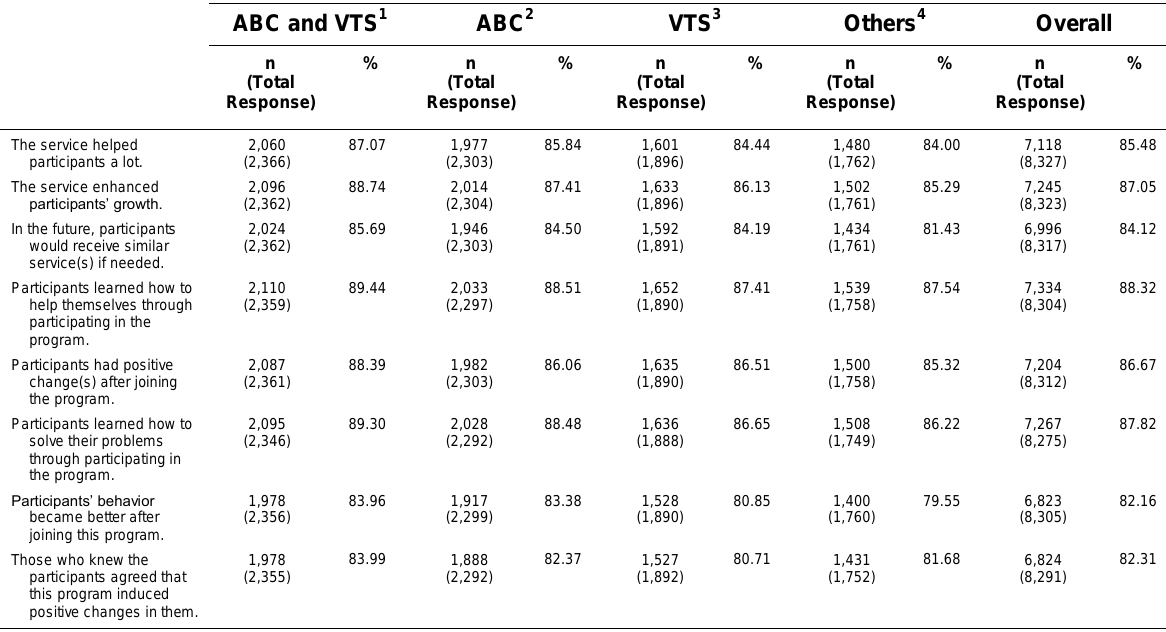
Comparison of the Positive Views towards the Tier 2 Program Effectiveness among